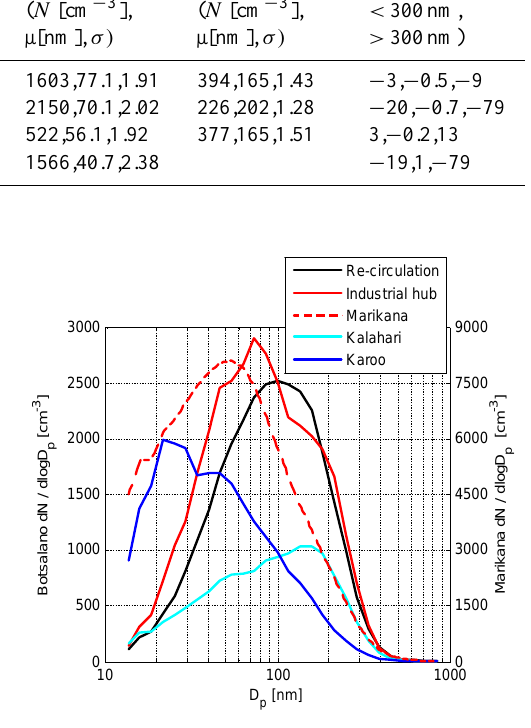
Fig. 13. Median size distributions for the four source regions de- fined for Botsalano (left axis) and the Marikana median size distri- bution (right axis). Modal fitting parameters are given in Table 6 for the source